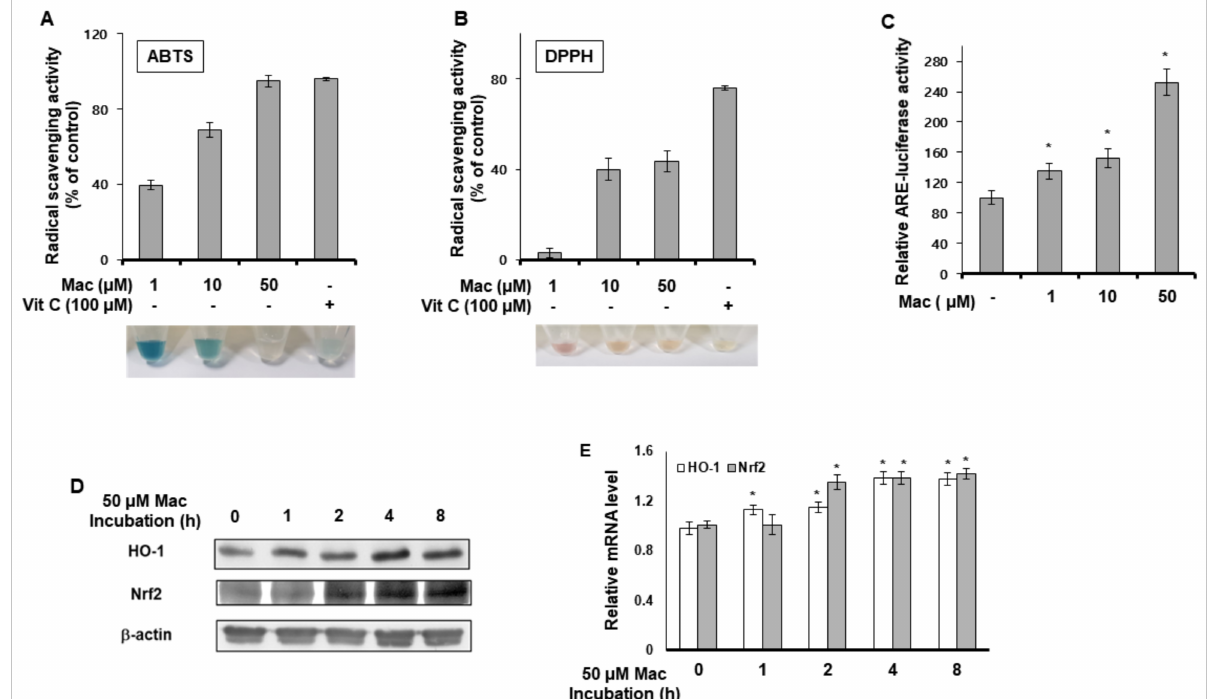
Figure 3. Maclurin showed radical scavenging property and activated ARE signaling. ( A , B ) ABTS ( A ) and DPPH ( B ) radical scavenging activity of maclurin. The results are shown as the mean ± SD of three replicates. ( C ) HaCaT cells were firstly transfected with the ARE-Luc reporter and a Renilla-luciferase vector using the DharmaFECT ® Duo transfection reagent. After incubation for 24 h, the cells were treated with maclurin for 14 h. The cells were lysed and subjected to the luciferase reporter assay. The data are shown as the mean ± SD of three replicates. * p < 0.05 vs. untreated control. ( D , E ) HaCaT cells were incubated with maclurin for the indicated time (1–8 h). The cells were harvested and subjected to Western blots and RT-PCR for HO-1 and Nrf2. The data are shown as the mean ± SD of three replicates. * p < 0.05 vs. untreated control. Vit C: vitamin C, Mac: